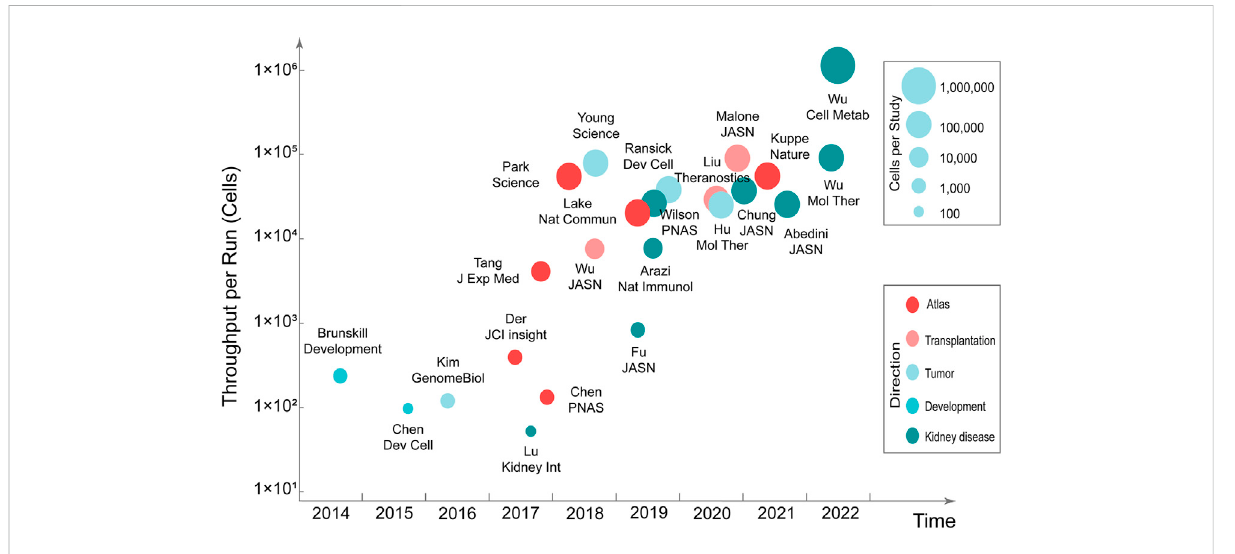
FIGURE 1 Timeline of single-cell transcriptomics studies in